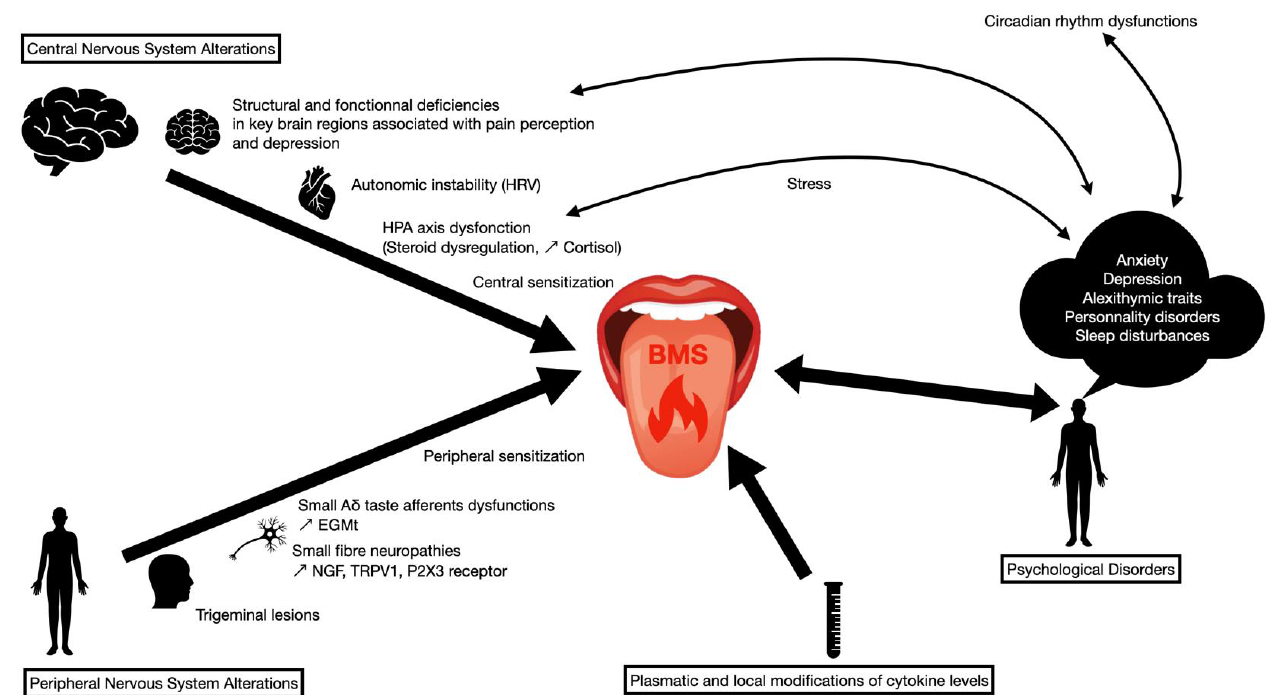
Figure 2. Pathophysiological hypotheses of burning mouth syndrome. HRV: heart rate variability; HPA axis: hypothalamic–pituitary–adrenal axis; EGMt: electrogustometric thresholds; NGF: nerve growth factor; TRPV1: transient receptor potential vanilloid type 1.